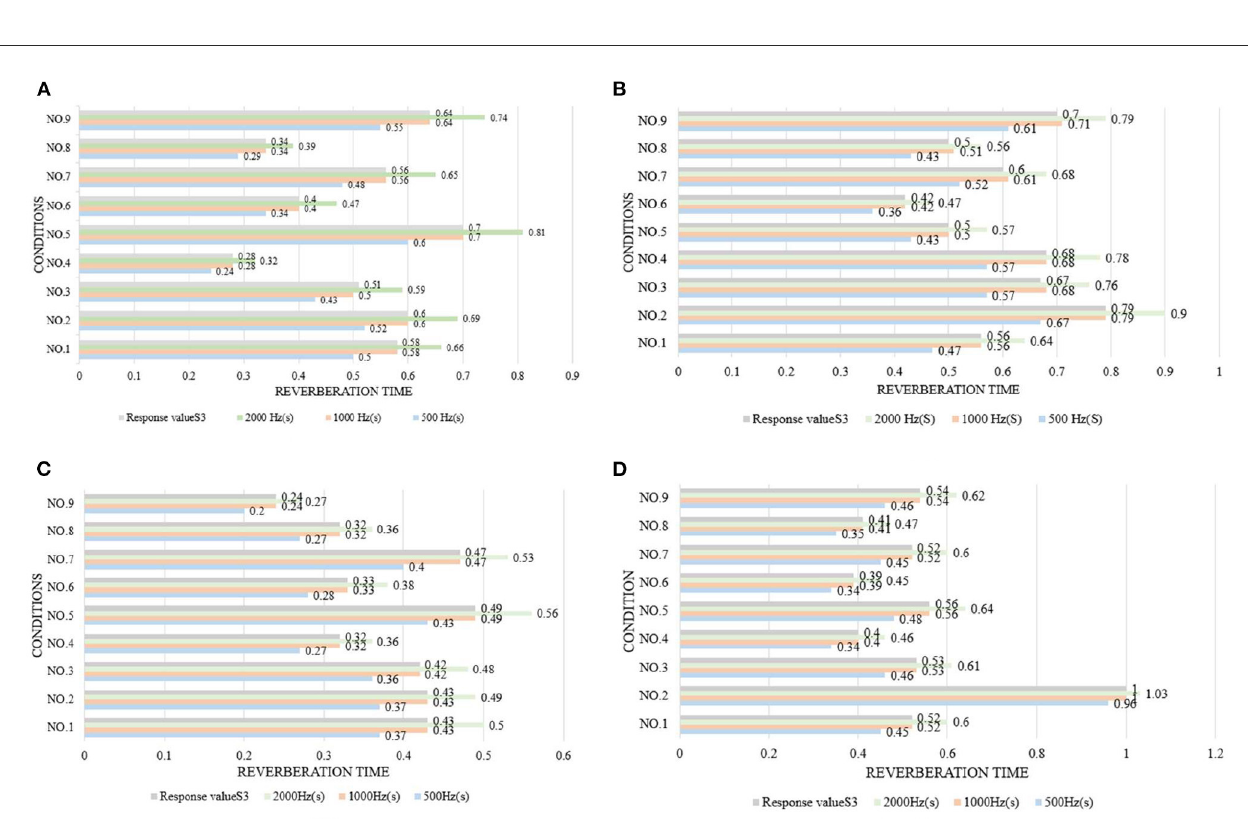
FIGURE6 Acoustic environment simulation results and response values for (A) TUAI, (B) TCAI, (C) TCSI, and (D) THAI. Image source: self-drawn by the